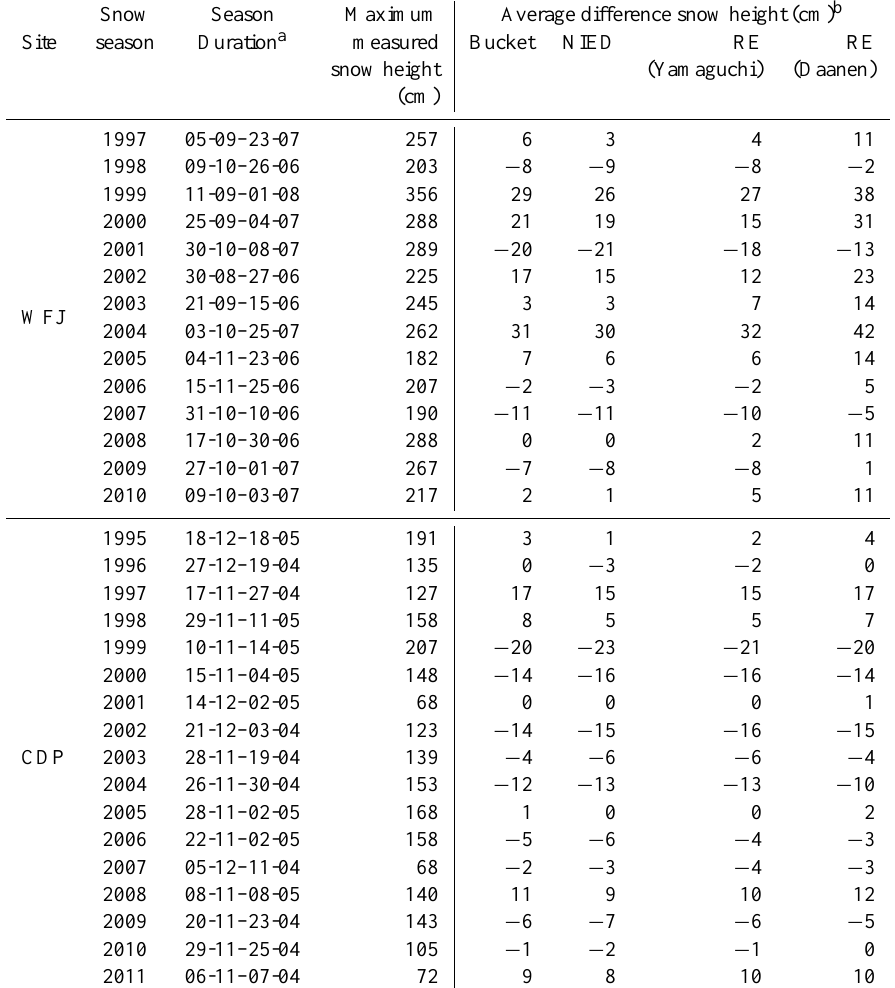
Table 1. Duration a , maximum measured snow height and seasonal average difference in measured and modelled snow height b for all snow